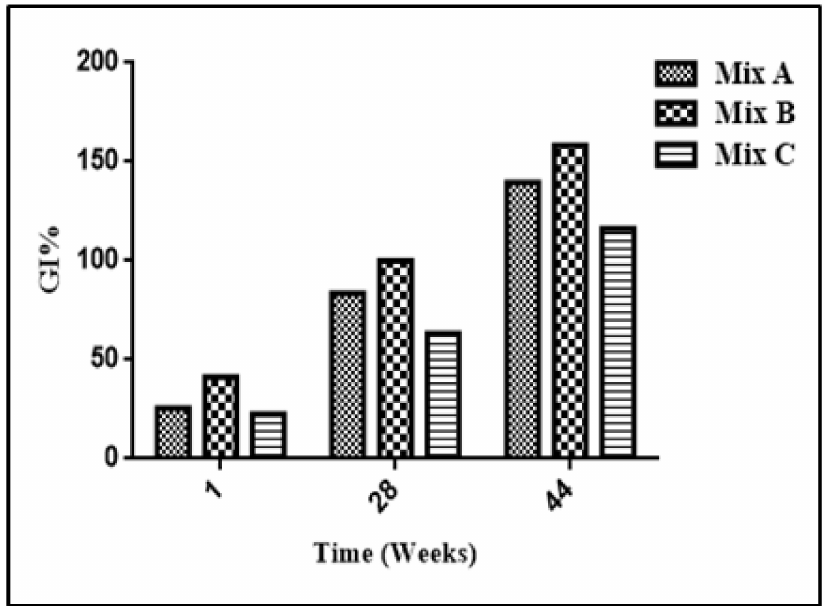
Figure 5. Evolution of phytotoxicity during the composting of mixes A , B , and C